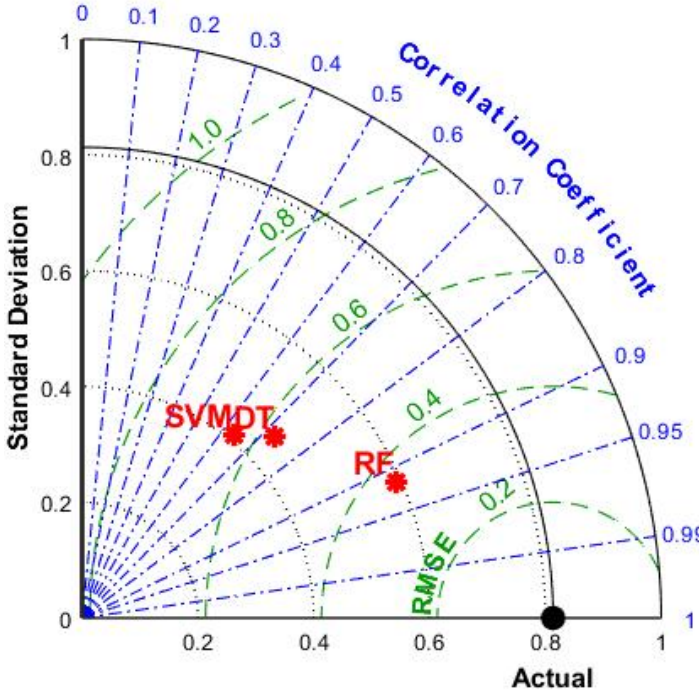
Figure 6. Radar plots for R values and RMSE values of SVM, DT, and RF.